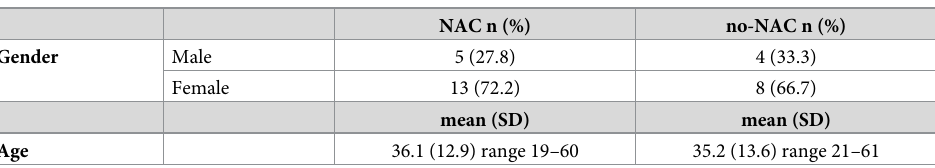
Table 1. Patient characteristics.